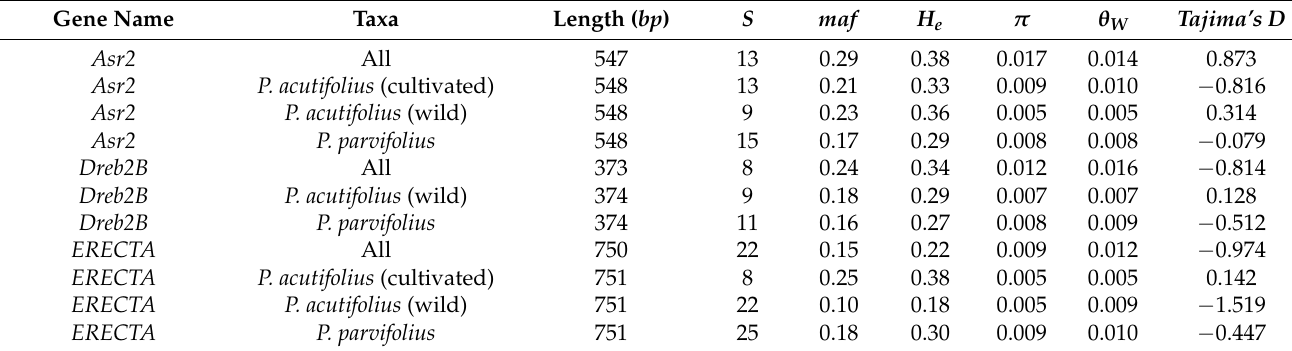
Figure 3. Principal component analyses (PCAs) of genetic polymorphism at ( A ) Asr2 , ( B ) Dreb2B , and ( C ) ERECTA -encoding candidate genes for drought tolerance in tepary bean s.l. ( P. acutifolius – parvifolius clade). Colors follow Figure 1, by taxonomic origin (Table S1): Green and blue for cultivated and wild P. acutifolius , red for P. acutifolius var. tenuifolius , and purple for P. parvifolius , latter two wild entries. First two principal genetic components allow comparisons with previously generated SNP [23] and SSR [10] data. Summary statistics calculated for the site frequency spectrum for each candidate gene in tepary bean s.l. revealed contrasting demographic/selection patterns (Table 2). In this analysis, Asr2 matched the expectations of a semi-structured pairwise mismatch distribution (positive Tajima’s D value of 0.873). Meanwhile, for Dreb2B and ERECTA -encoding genes, signatures of directional/purifying selection (negative Tajima’s D values of −0.814 and −0.974, correspondingly) were observed, likely in favor of adaptive alleles selectively advantageous. Table 2. Summary statistics of the site frequency spectrum at Asr2 , Dreb2B , and ERECTA -encoding candidate genes for drought tolerance in tepary bean s.l. ( P. acutifolius – parvifolius clade). Depicted summary statistics include S : Number of polymorphic (segregating) sites (enforced maf > 0.05 for the entire dataset), maf : Average minimum allele frequency, H e : average expected heterozygosity—as a measure of the polymorphism information content (PIC), π : Nucleotide diversity [64], θ W : Theta of Watterson—per site from S [65], and Tajima’s D [66]. Only variable taxa with enough sampling to make per-population computations reliable are kept.